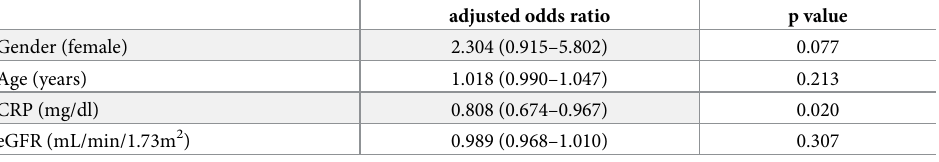
Table 2. Multivariate logistic regression analysis of baseline characteristics associated with non-cavity